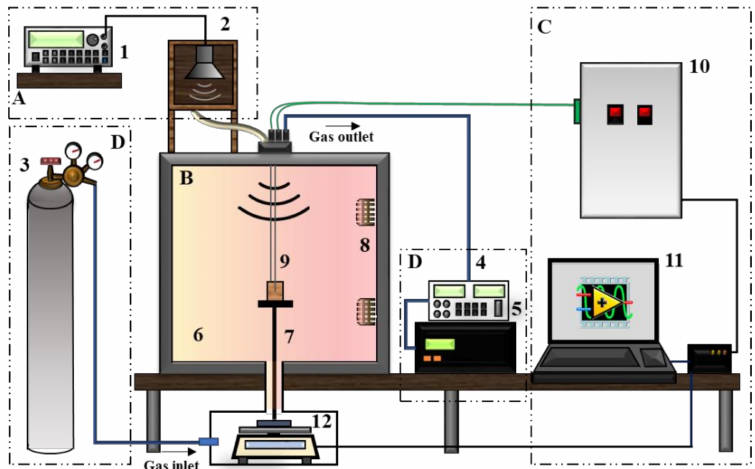
Figure 1. General diagram of the thermoacoustic torrefaction system. The device involved four subsystems: acoustic (A), heat treatment (B), power and recording (C), and gas feeding (D).